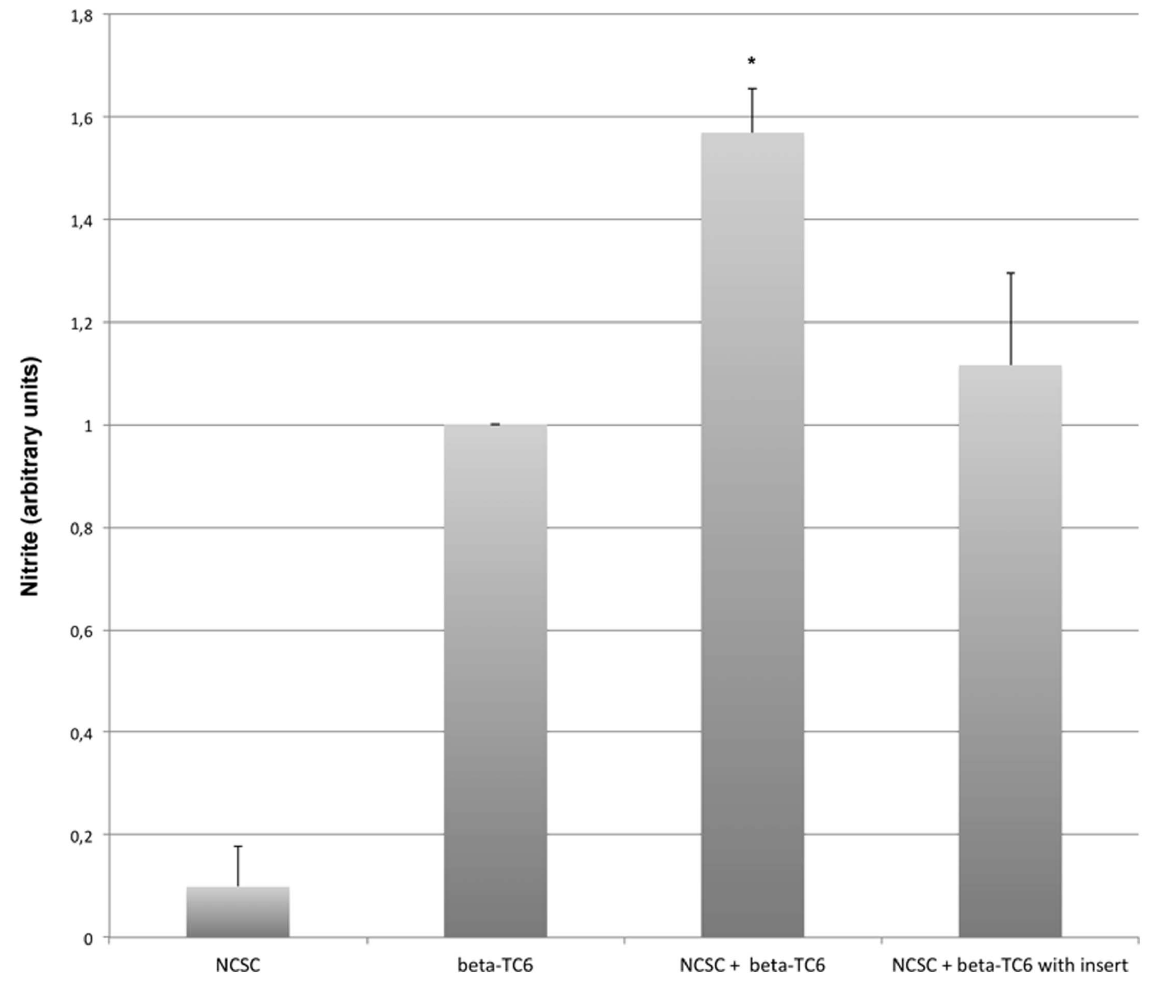
Figure 2. Co-culture of beta-TC6 cells with NCSCs in direct contact results in increased nitrite production in response to cytokine exposure. NCSCs were plated on laminin-coated plates or inserts and after three days beta-TC6 cells were added. After 48 hours of co-culture IL-1 b (20 ng/mL) and IFN- c (20 ng/mL) was added during another 48 hour culture period. At the end of this culture period culture medium samples were analysed for nitrite using the Griess reagent. Results are means 6 SEM for 4 independent experiments. * denotes p , 0.05 using Student’s paired t- test.